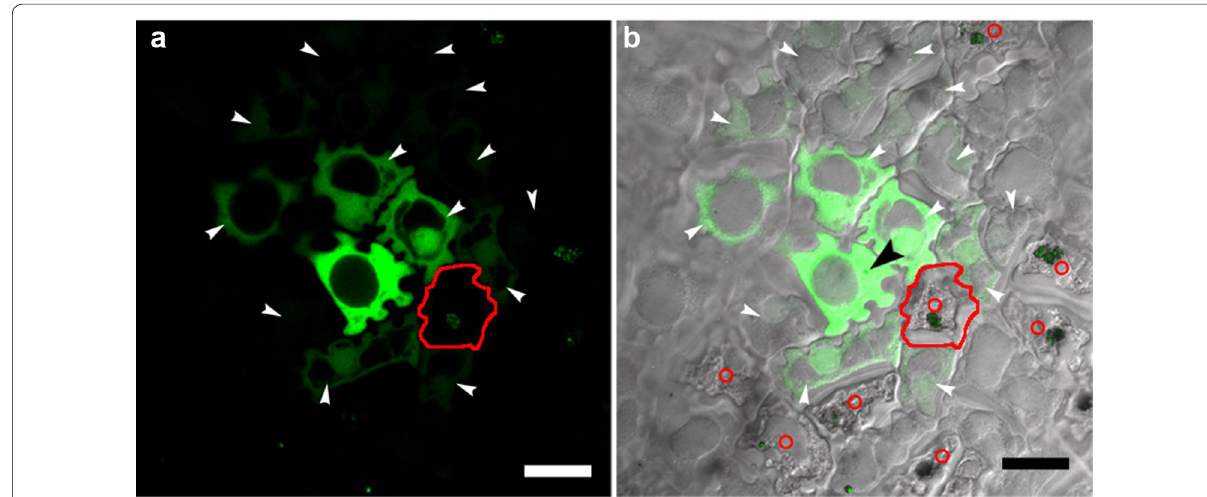
Fig. 2 Movement of GmPM16‑GFP fusion proteins in soybean endosperm. The cells were imaged by a epi‑fluorescence and b overlapping fluorescence and phase contrast. The positions of gold particles in nuclei are marked by a black arrowhead in b . The fluorescent cells caused by fusion proteins movement are marked by white arrowheads. The red circles indicate the destroyed cells containing gold particles. Scale bars 20 =